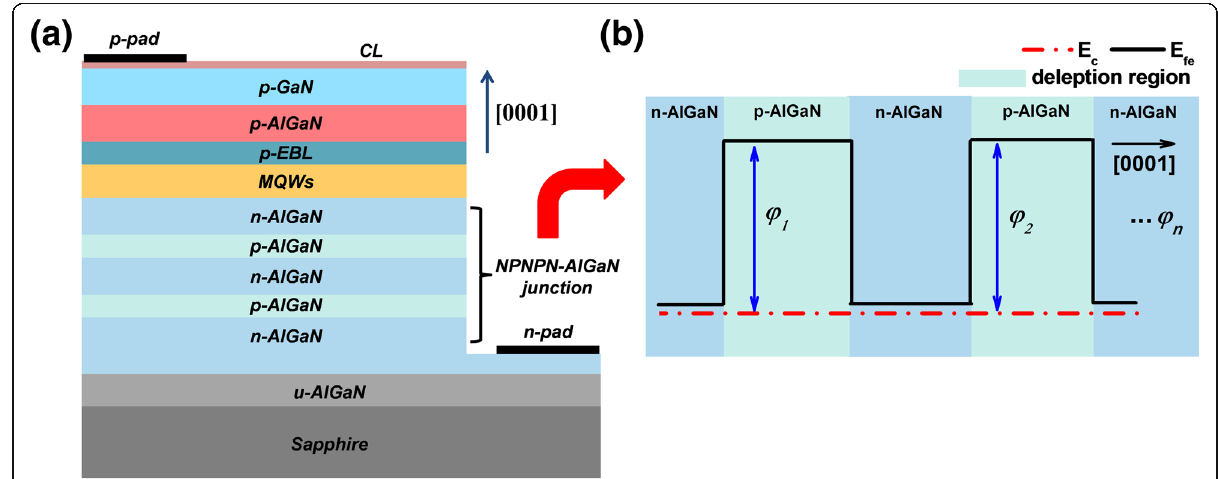
Fig. 1 a Schematic structures for the NPN-AlGaN LED. b Schematic conduction band profile for the NPNPN-AlGaN structure having two NPN- AlGaN junctions; we define the barrier heights for each NPN-AlGaN junction as φ 1 , φ 2 , and φ n , and n is the number of NPN-AlGaN